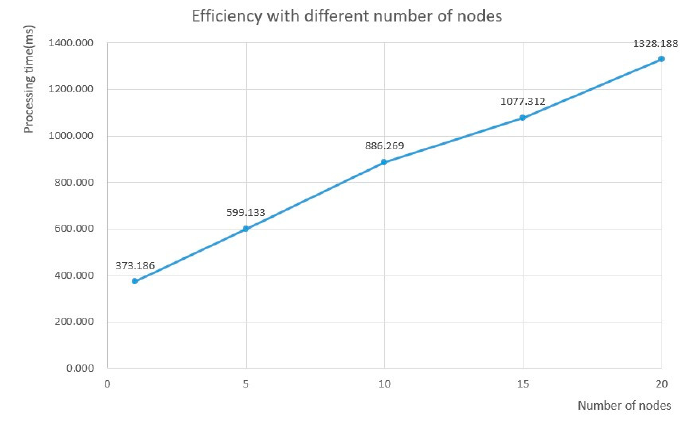
Table 1. Processing time with different numbers of nodes.